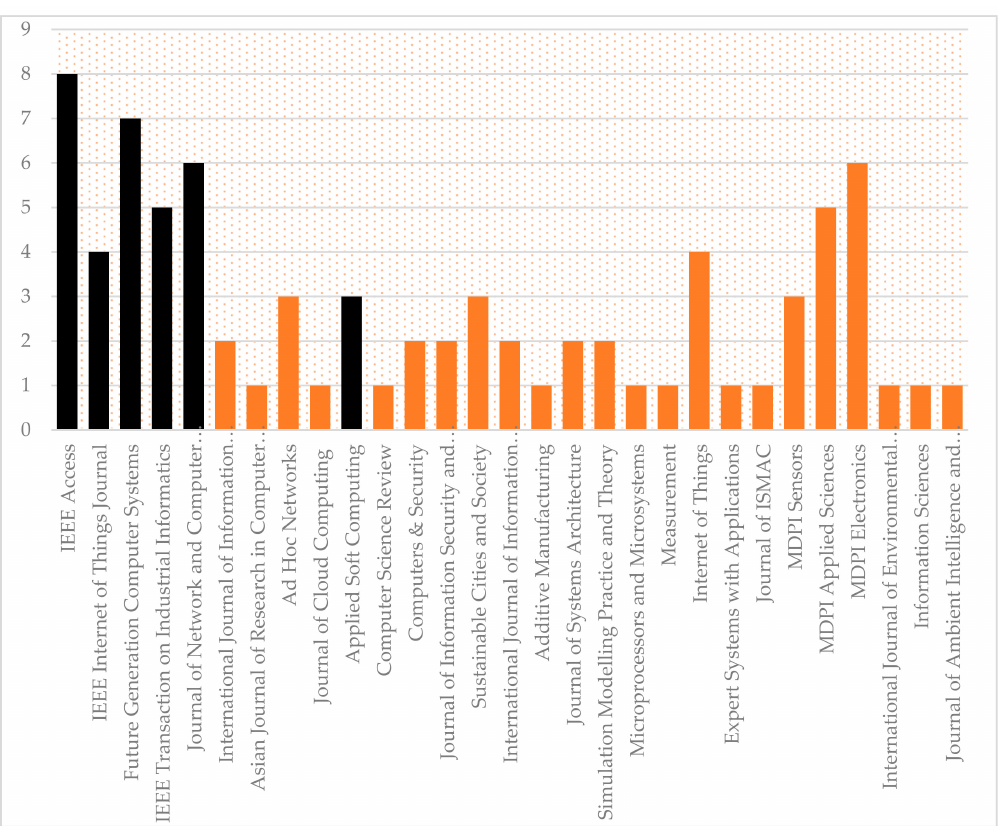
Figure 4. Distribution of studies based on the journals.